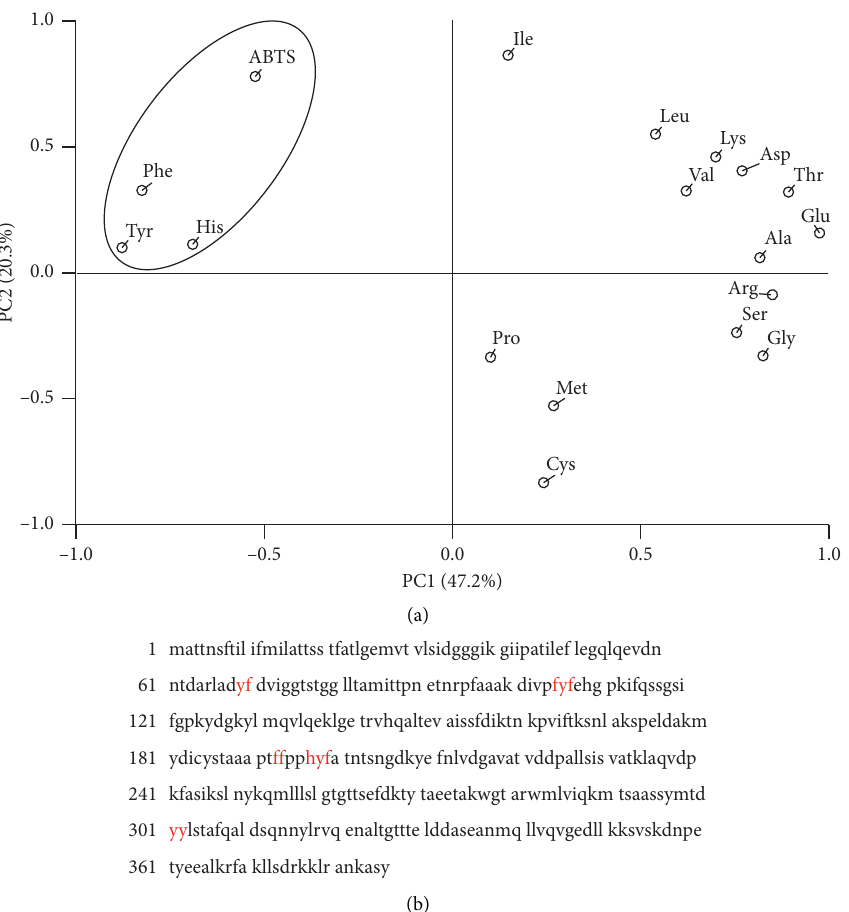
Figure 1: Component matrix plot of amino acid compositions in PPH fractions (a) and amino acid sequence of patatin from NCBI